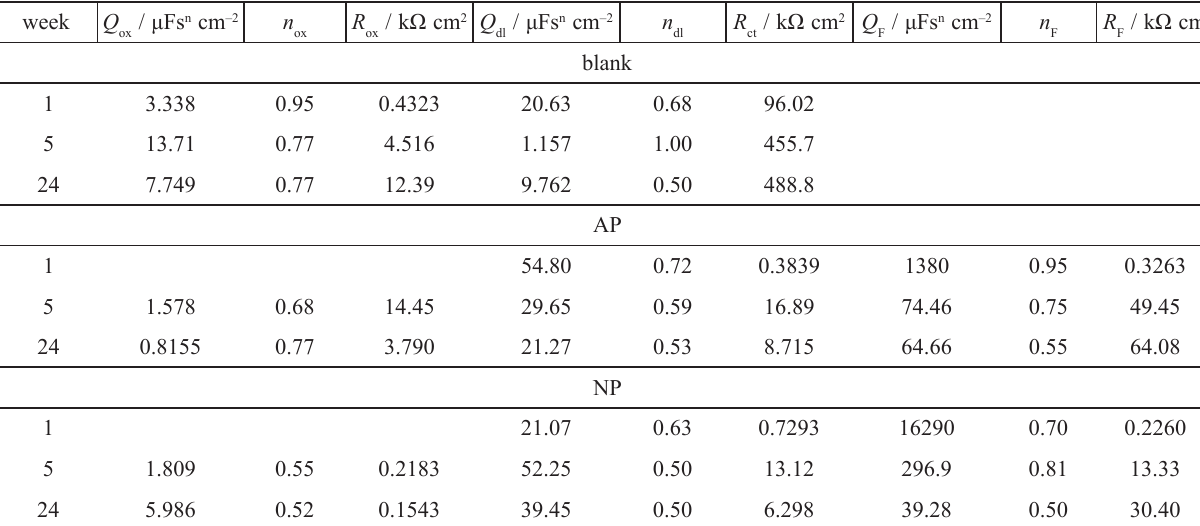
Table 3 – EIS data for CuSn9Zn2Pb samples